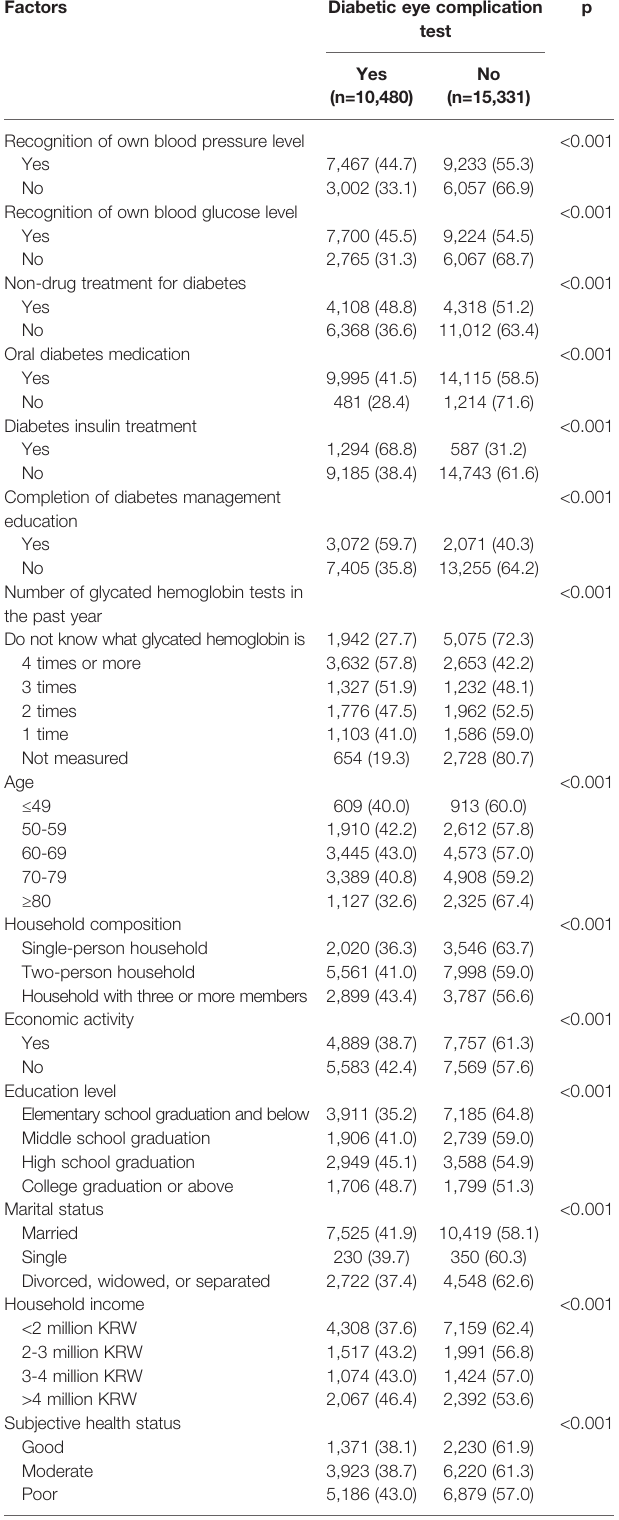
TABLE 1 | Characteristics of subjects according to the diabetic eye complication test (fundoscopic examination), n (%).